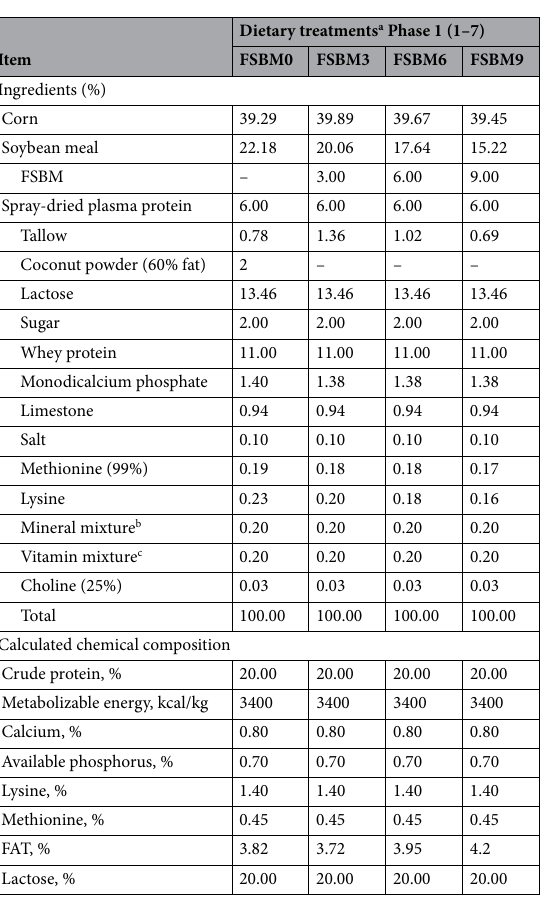
Table 2. Composition of weaning pig diets (as fed-basis). a FSBM0, FSBM3, FSBM6 and FSBM9 diets were made by substituting fermented soybean meal for 0, 3, 6 and 9% soybean meal. b Provided per kg diet: Fe, 100 mg as ferrous sulfate; Cu, 17 mg as copper sulfate; Mn, 17 mg as manganese oxide; I, 0.5 mg as potassium iodide; and Se, 0.3 mg as sodium selenite. c Provided per kilograms of diet: vitamin A, 10,800 IU; vitamin D3, 4000 IU; vitamin E, 40 IU; vitamin K3, 4 mg; vitamin B1, 6 mg; vitamin B2, 12 mg; vitamin B6, 6 mg; vitamin B12, 0.05 mg; biotin, 0.2 mg; folic acid, 2 mg; niacin, 50 mg; D-calcium pantothenate, 25